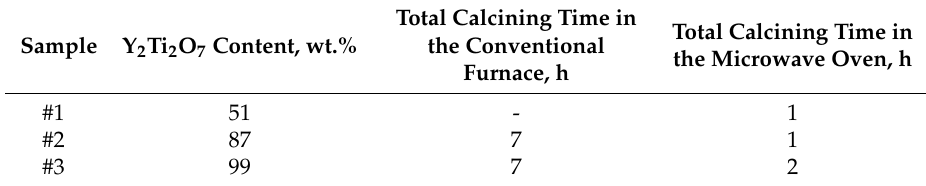
Table 2. Content of Y2Ti2O7 in the samples after di ff erent heat treatments.